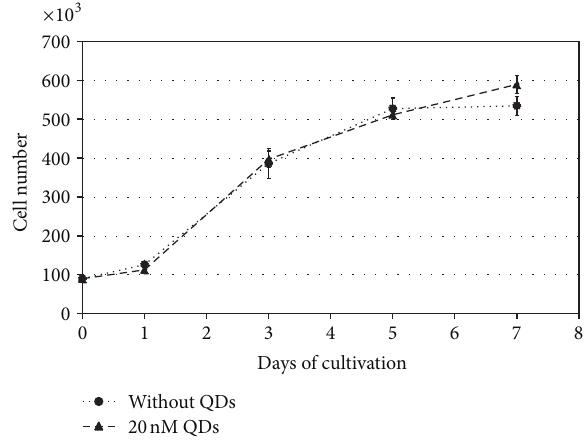
Figure 8: Growth curve of QD labeled and unlabeled stem cell populations during 7 days of cultivation. Cells were counted on days 1, 3, 5, and 7. Mean cell count was calculated from three experiments.